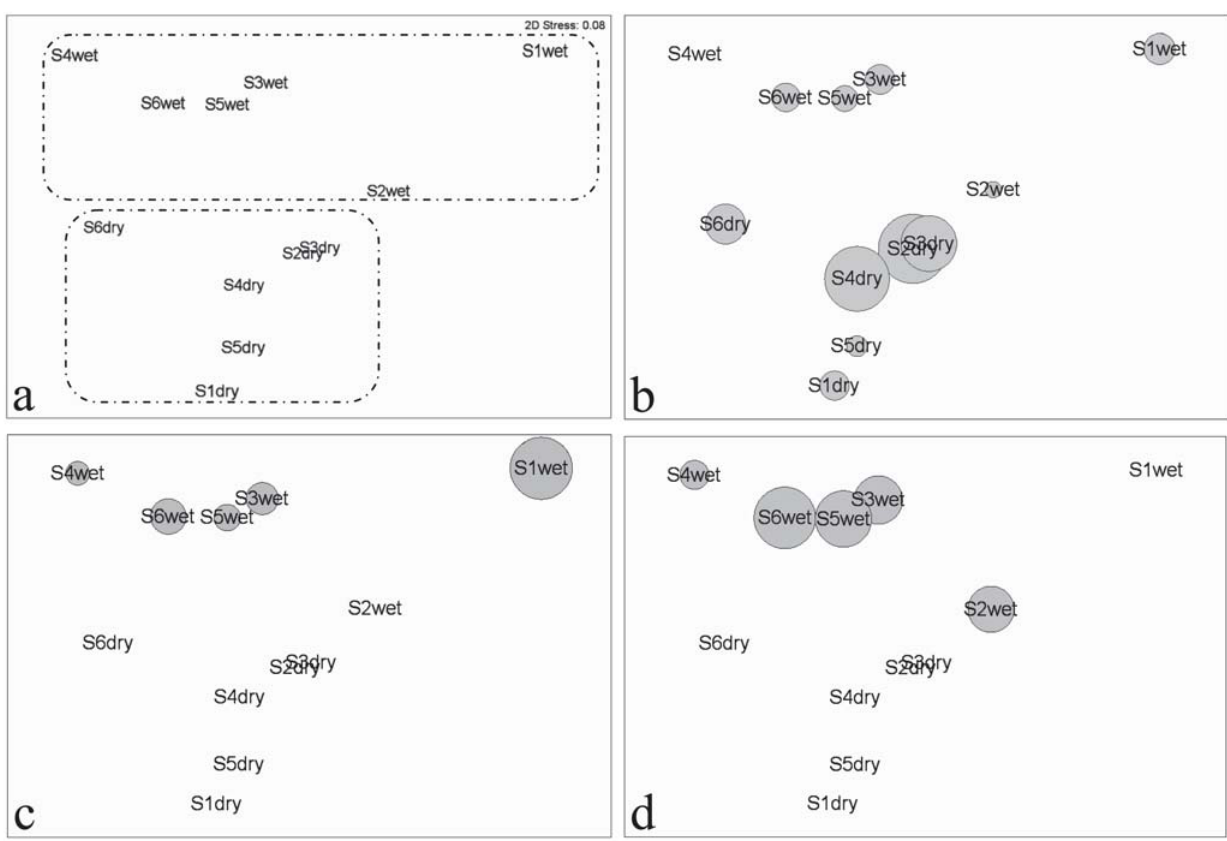
Fig. 4. (a) Ordination resulting from Nonmetric Multidimensional Scaling Analysis (NMDS) with percent composition by number of feeding items from fishes of six stream stretches (S1-S6) in the dry and wet periods. (b, c, d) Contribution (the larger the circle, the greater the percent composition by number) of Ceratopogonidae larvae (b), Coleoptera larvae (c), and Collembola (d) to the fishes’ diet. A stress of 0.08 corresponds to a good ordination with no real prospect of a misleading interpretation (Clarke & Warwick,